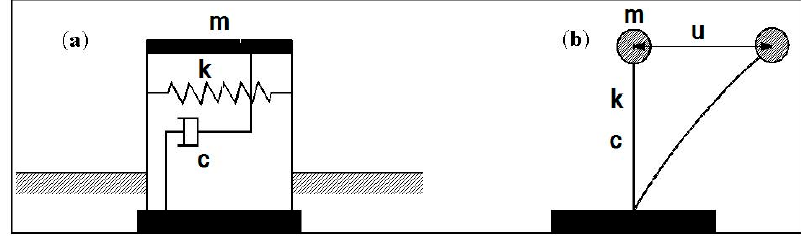
Figure 1. ( a ) Structural building model; and ( b ) the idealized SDOF mathematical model.